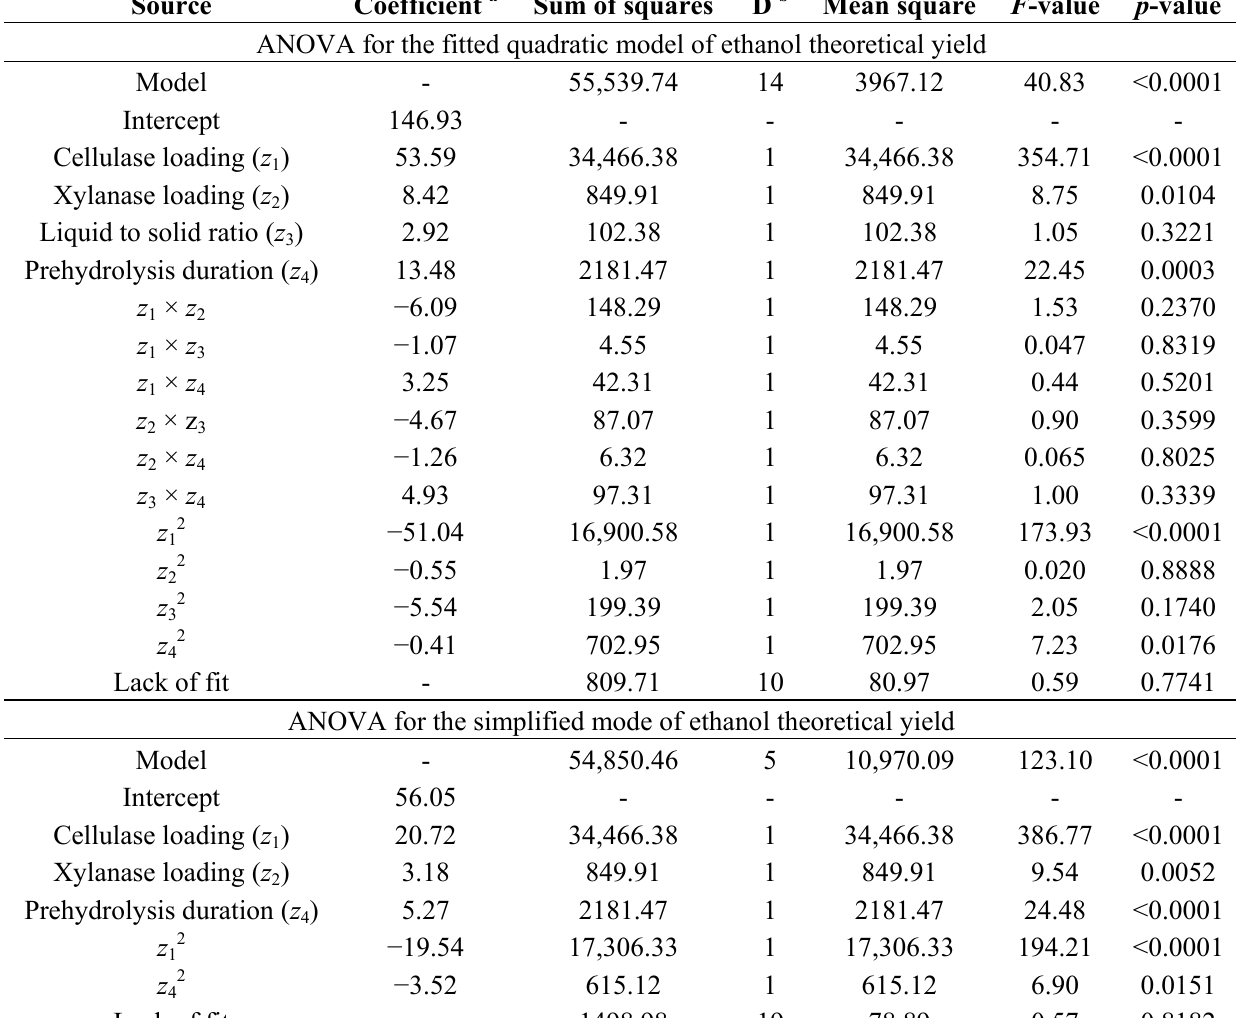
Table 2. ANOVA for the fitted quadratic model and simplified mode a